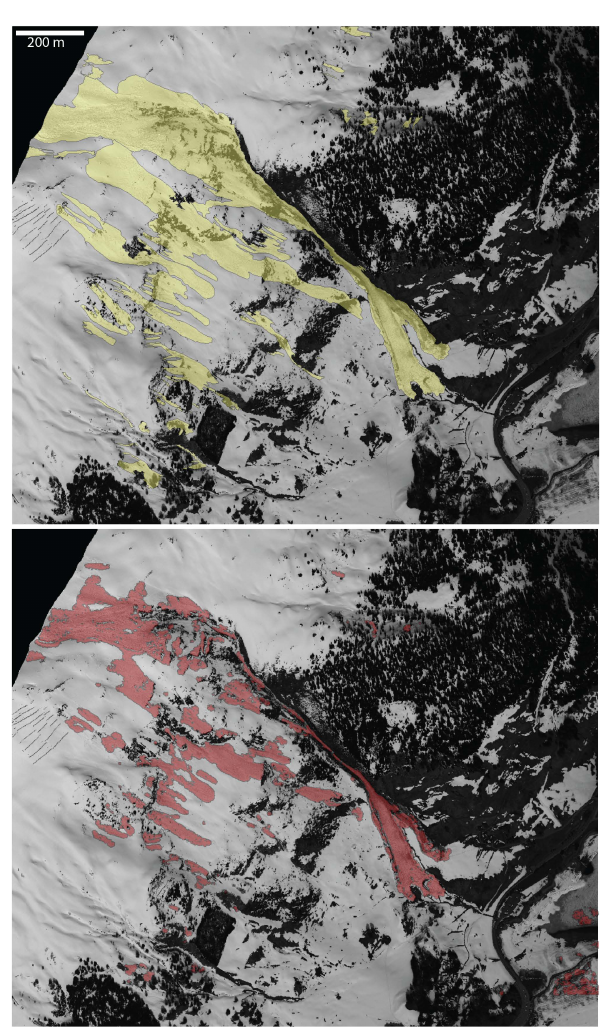
Fig. 7. Leica panchromatic imagery collected near the town of Davos. The primary target of this image is the Salezer Avalanche (March, 2008). Image (a) (above) illustrates manual mapping of snow avalanche deposits in ArcGIS, while image (b) (below) is processed automatically in eCognition and then vi- sualised in